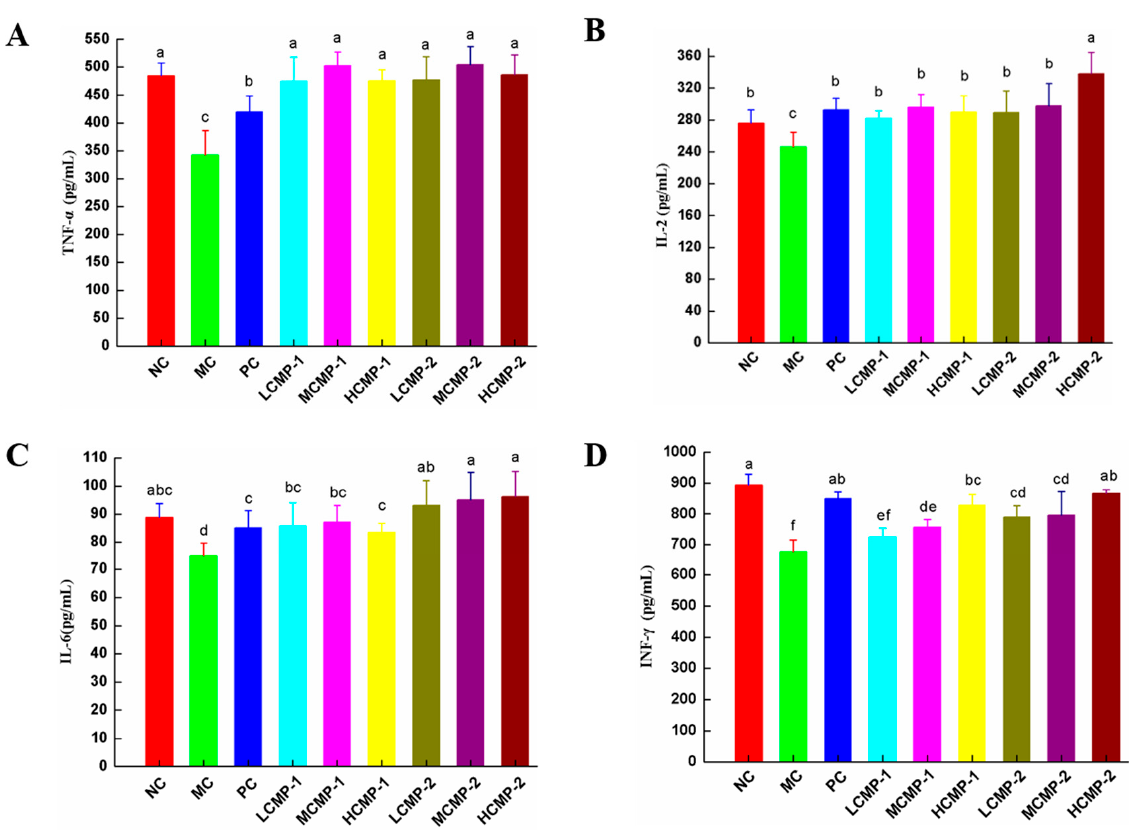
Figure 3. Effects of CMP-1 and CMP-2 on cytokine TNF- α ( A ), IL-2 ( B ), IL-6 ( C ), INF- γ ( D ) in serum. The data were ex- pressed as means ± SD (n = 10). Different superscript small letters (a–f) are significantly different ( p < 0.05).